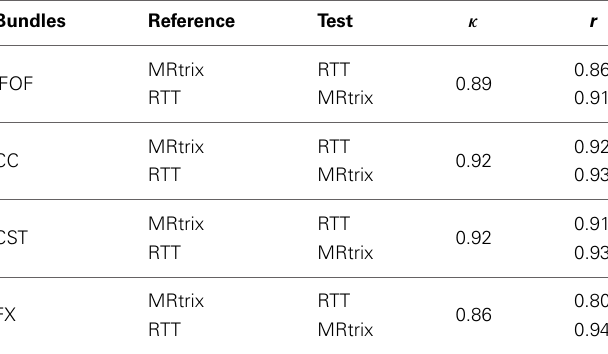
Table 5 | Statistical pair-wise comparison between MultiPeak-RTT and MRtrix results using a 1.5mm overlap tolerance.